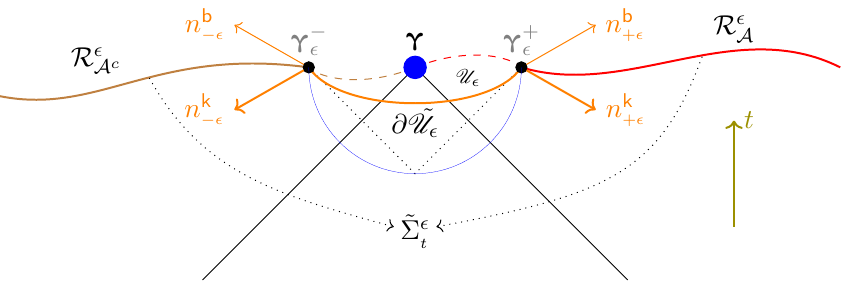
˜ U (orange curve) whose intersection with ˜Σ is not orthogonal. We have Figure 8. A choice of ∂ (cid:15) t indicated its timelike normal at the locus where the regulating surface intersects the bulk Cauchy slice both into the ket part of the spacetime, as well as the corresponding normal from the bra side. The latter has been reflected up into the future to make clear that in the limit of the smooth join the inner product is between anti-parallel vectors owing to the opposite time-orientation on M b relative to that on M k